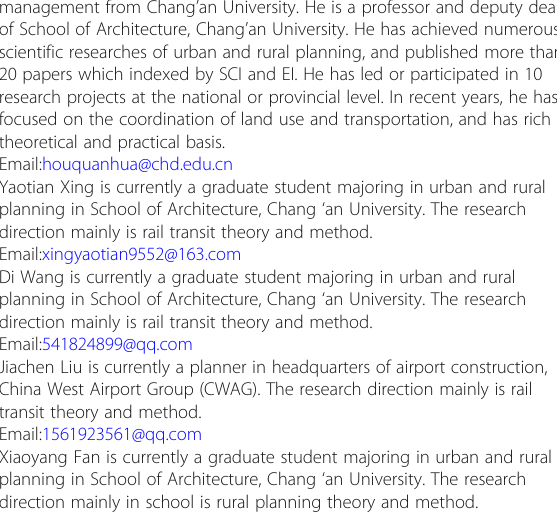
ð i Þ statistics of the indicator